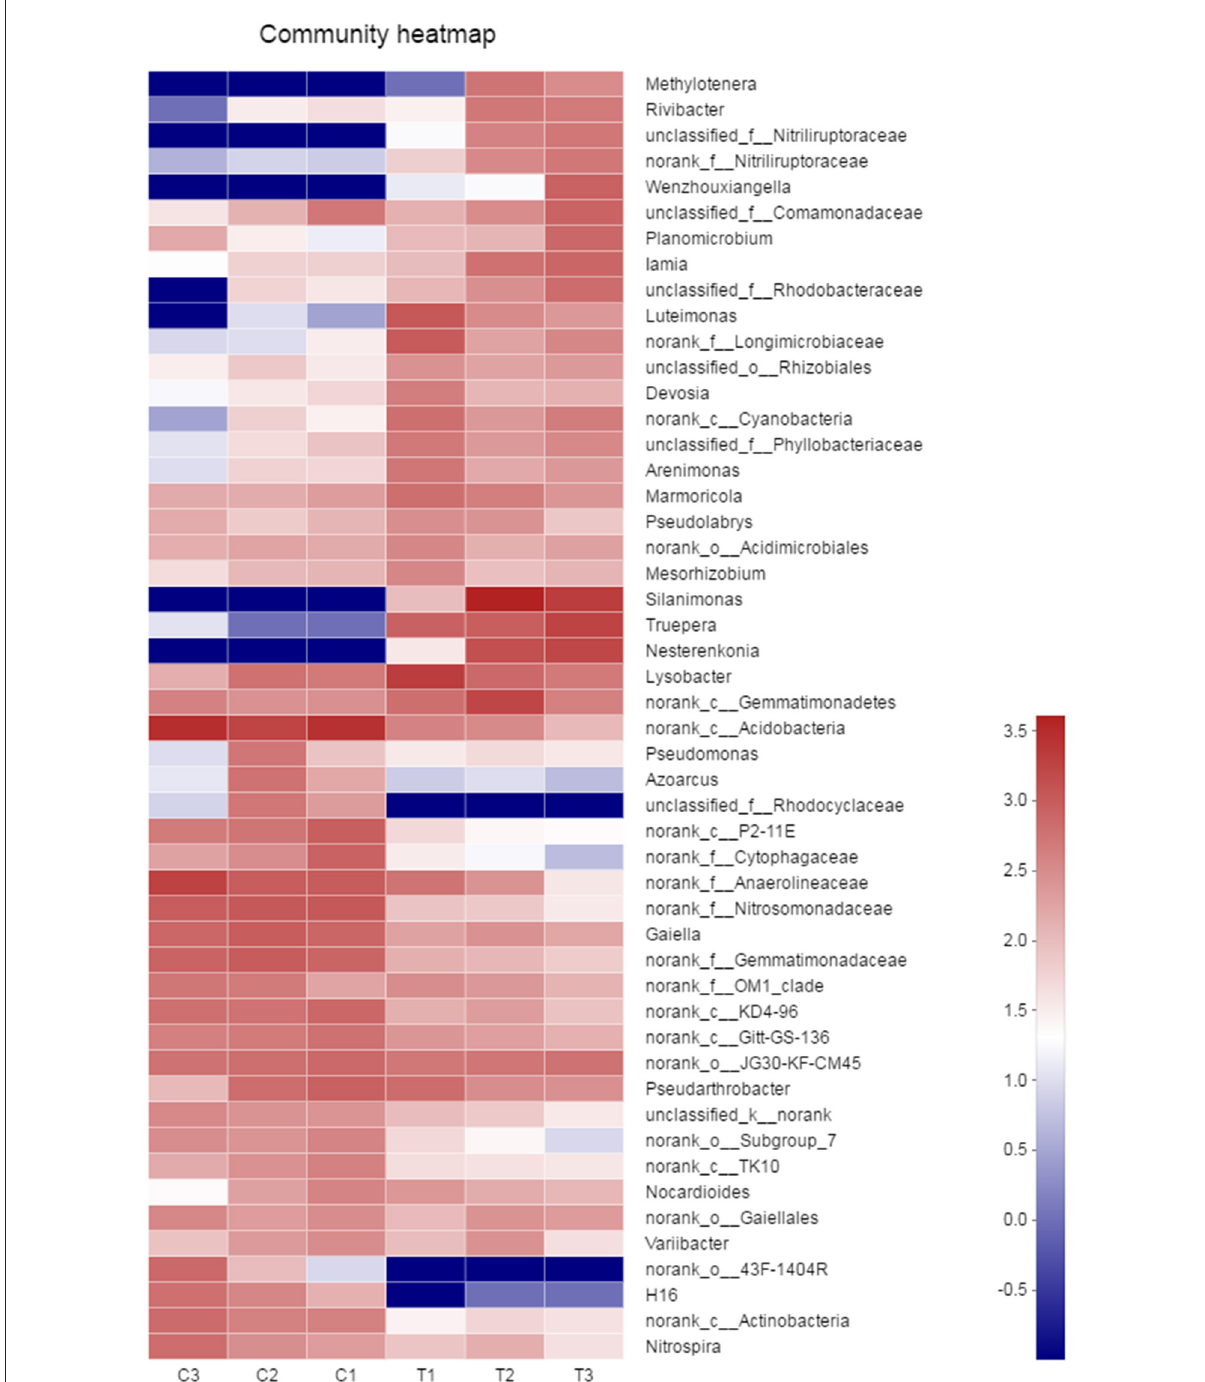
FIGURE7 The similarity and differences in bacterial community structures in the soil samples were analyzed by heatmap. All data in the experiment represent three independent experiments.